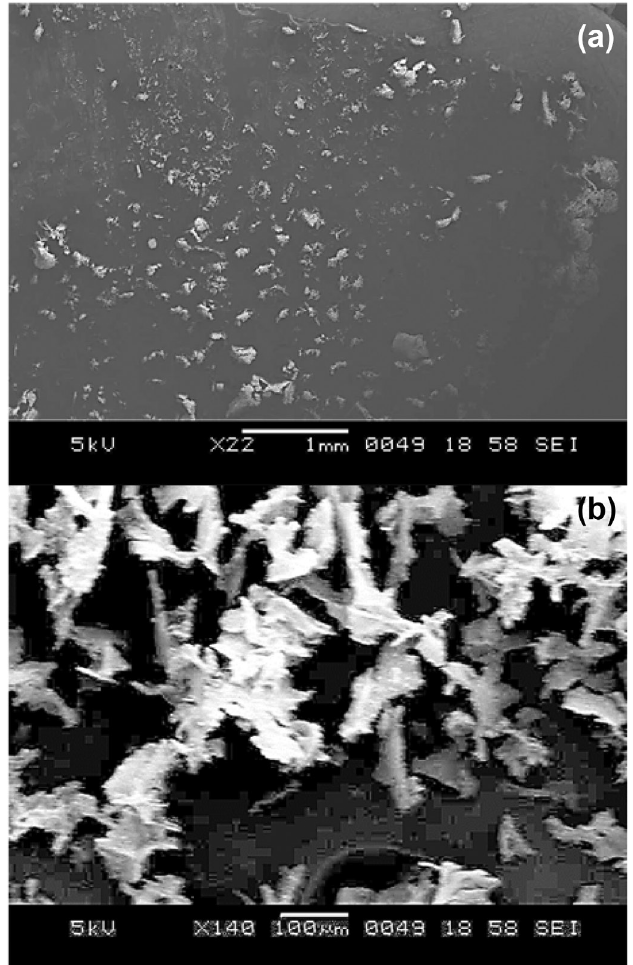
FIGURE 2 - SEM of (a) Irbesartan and (b) Irbesartan-loaded SLN F3